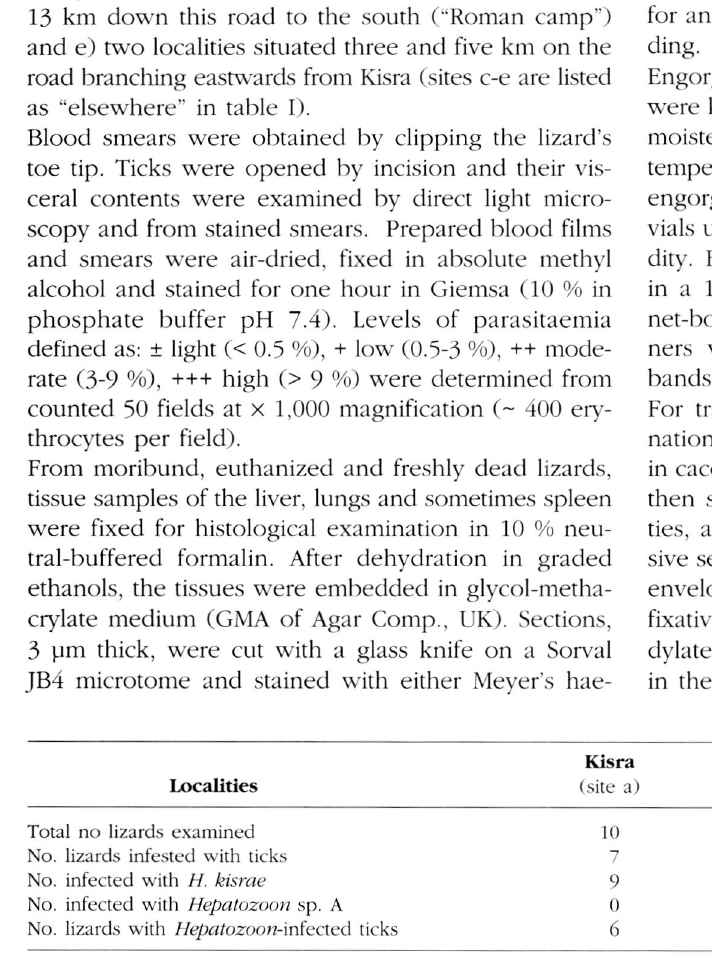
Table I. - Summary of numbers of starred lizards examined from localities in Samaria, found infected by Hepatozoon spp. and found infested by Hepatozoon- infected and non-infected